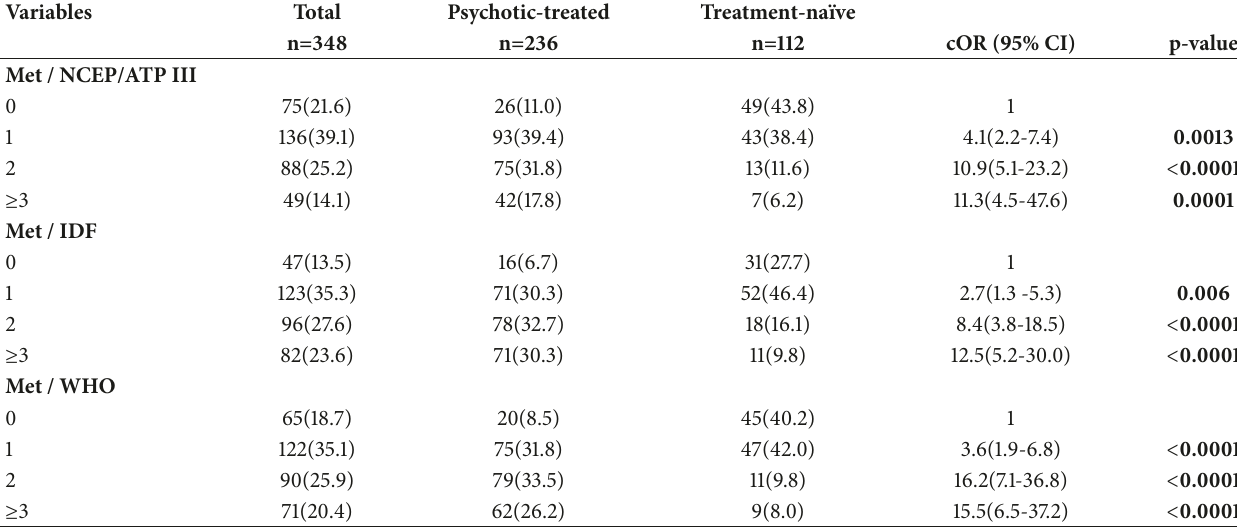
Table 2: MetS among psychotic-treated and treatment-na¨ıve studied